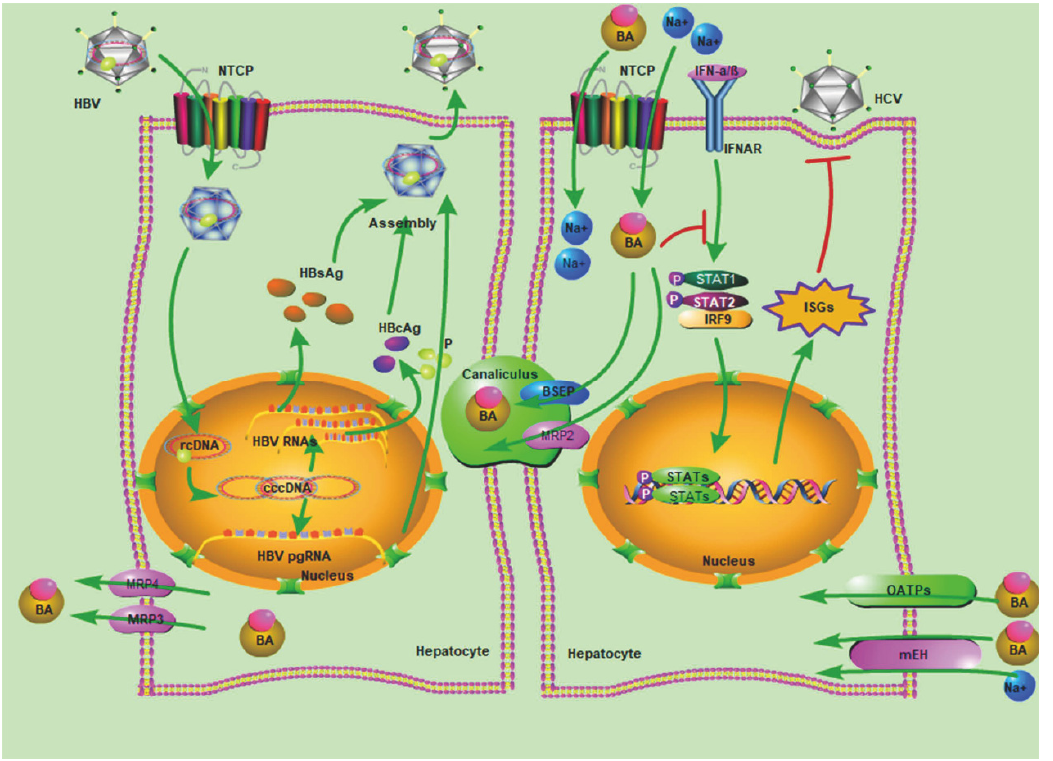
Figure 1. Multiple functions of NTCP. Initially, bile acids (BAs) are transported by NTCP in hepatocytes. This figure shows the process of bile acid transport. Secondly, HBV enters cells via NTCP. The entire lifecycle of HBV includes attachment, entry, uncoating and nuclear import, cccDNA formation, transcription, translation, encapsidation, replication, assembly, and secretion. In the left cell, we show the complete lifecycle of HBV. Thirdly, the bile acids transported from the extracellular environment via NTCP inhibit the expression of ISGs, thereby inhibiting HCV infection. NTCP, Na + -taurocholate co- transporting polypeptide; BSEP, bile salt export pump; MRP4, multidrug resistance-associated protein 4; MRP3, multidrug resistance-associated protein 3; MRP2, multidrug resistance-associated protein 2; OATPs, organic-anion-transporting polypeptide; mEH, microsomal epoxide hydrolase; ASBT, apical sodium-dependent bile salt transporter.